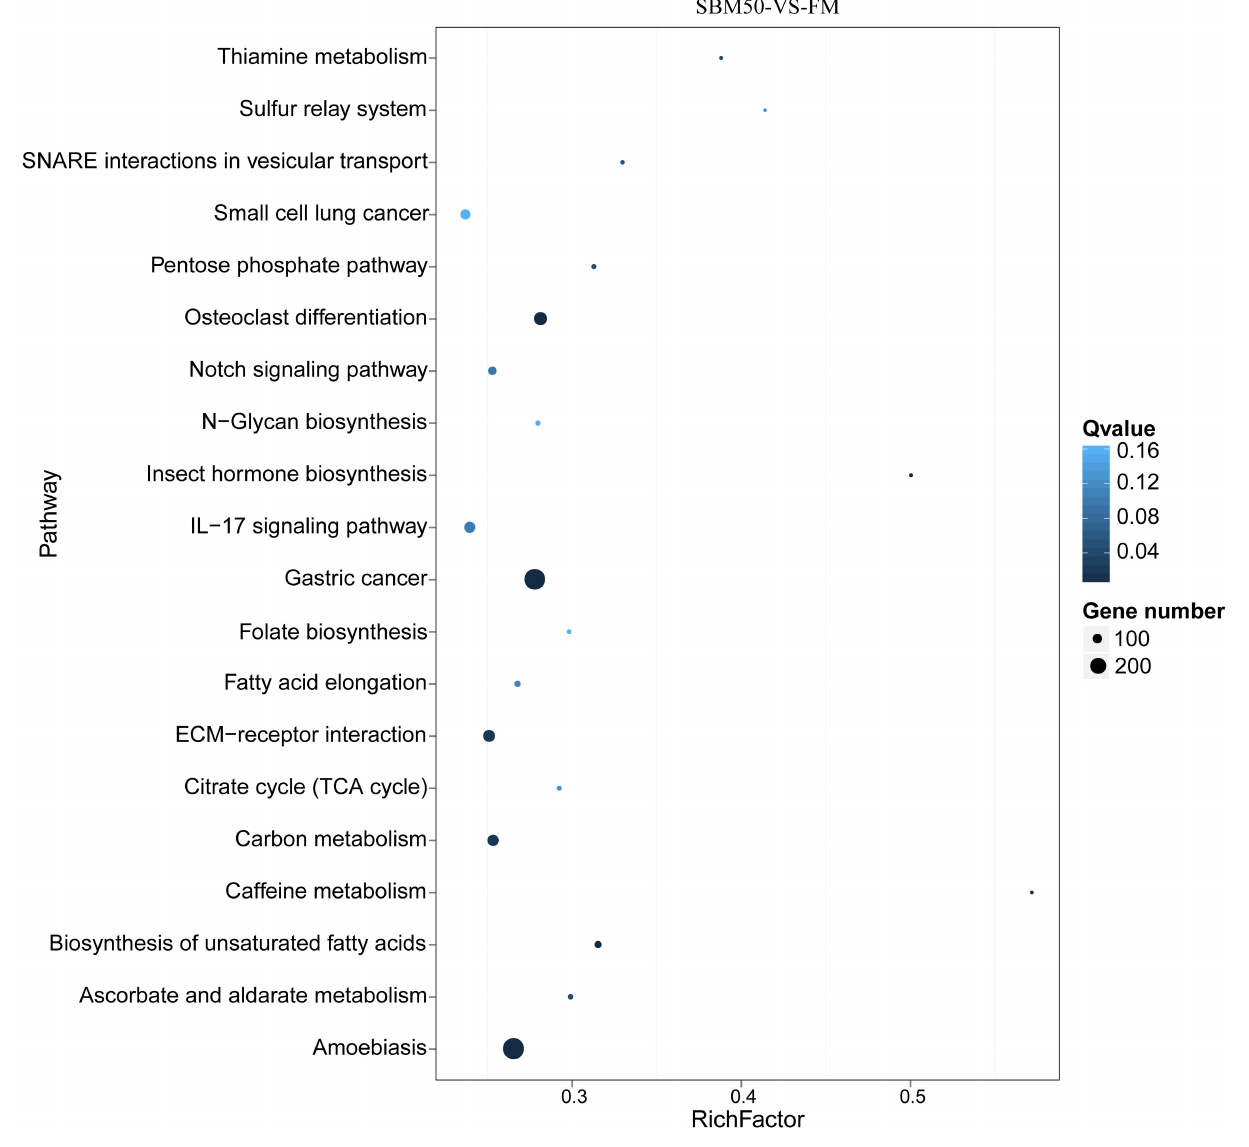
FIGURE 5 | The top 20 KEGG pathways of predicted target genes in FM and SBM50 groups. The horizontal axis represents the rich ratio, and the vertical axis represents the name of the KEGG pathway. The size of the bubble represents the number of genes annotated to the pathway. The color represents the enriched Q